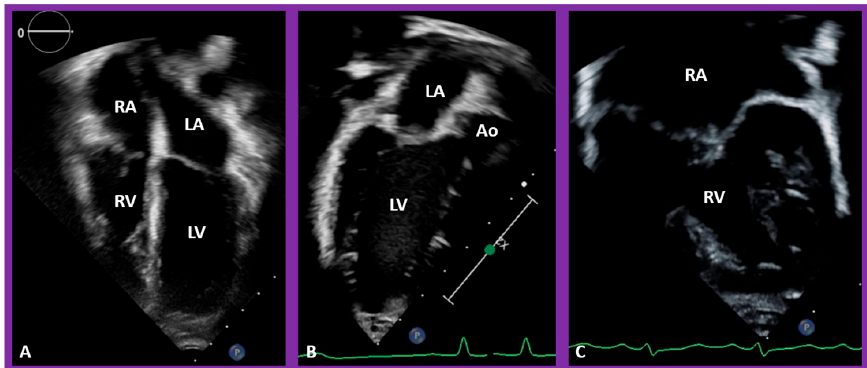
Figure 34. Echo images demonstrating finely trabeculated left ventricle (LV) ( A , B ) and coarsely trabeculated right ventricle (RV) ( A , C ) in apical precordial views. The LV trabeculations are barely seen in ( A ) but are better seen in ( B ). Similarly, the RV trabeculations are better seen in ( C ). Aorta (Ao), left atrium (LA), and right atrium (RA) are labeled.